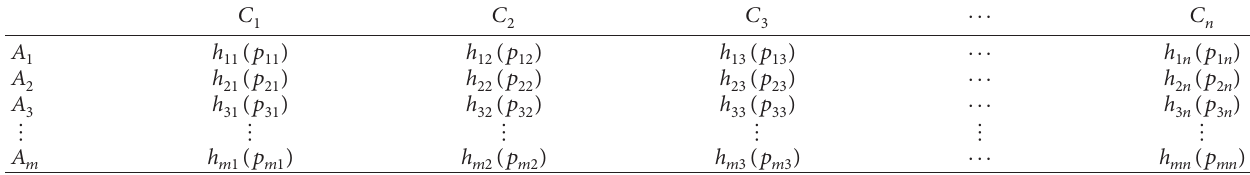
Table 3: Probabilistic hesitant fuzzy decision matrix given by the experts.